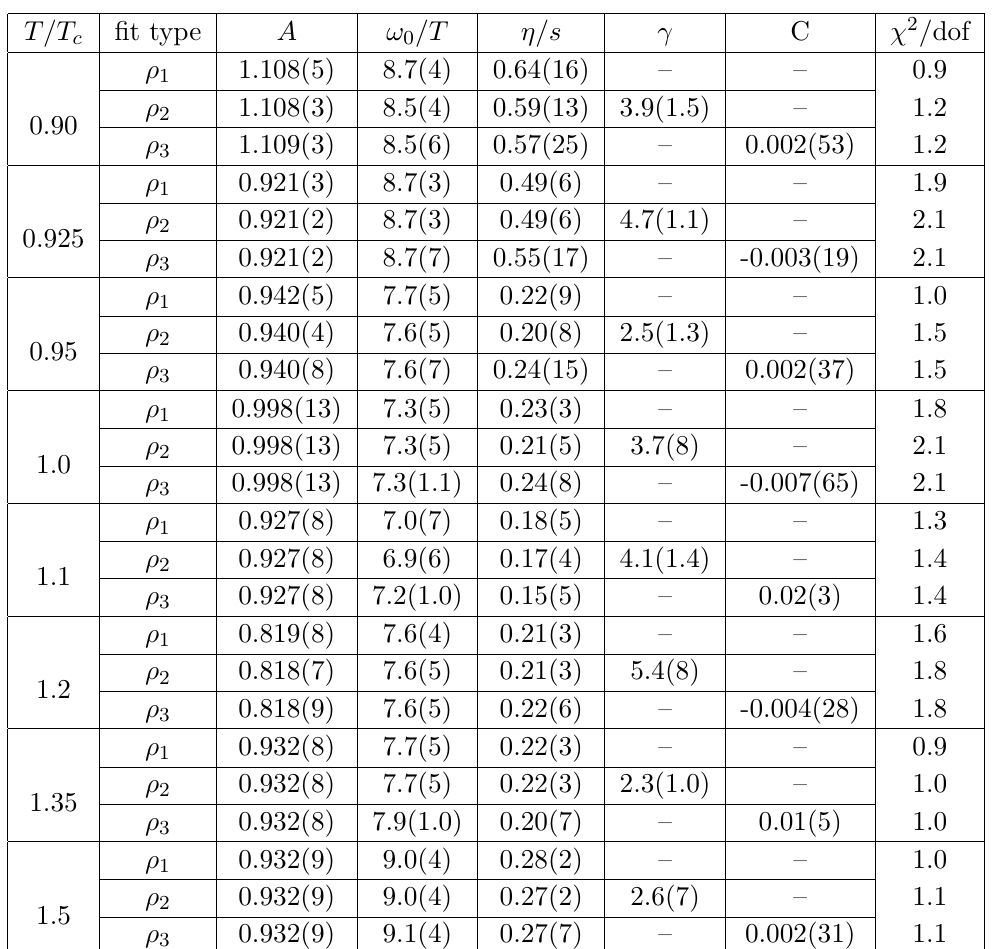
Table 1 . The parameters of the functions (cid:26) 1 ( ! ), (cid:26) 2 ( ! ), (cid:26) 3 ( ! ) obtained from the (cid:12)t of the lattice data. Instead of the parameter B in the (cid:12)fth column we show the ratio (cid:17)=s = (cid:25)B=s . We (cid:12)t the lattice data (14 > x =a > 2) for each temperature by formula (2.2) 0 with spectral functions (3.1), (3.2), (3.3). In table 1 we show the parameters of func- tions (3.1), (3.2), (3.3) obtained through this (cid:12)t. Instead of the parameter B in the